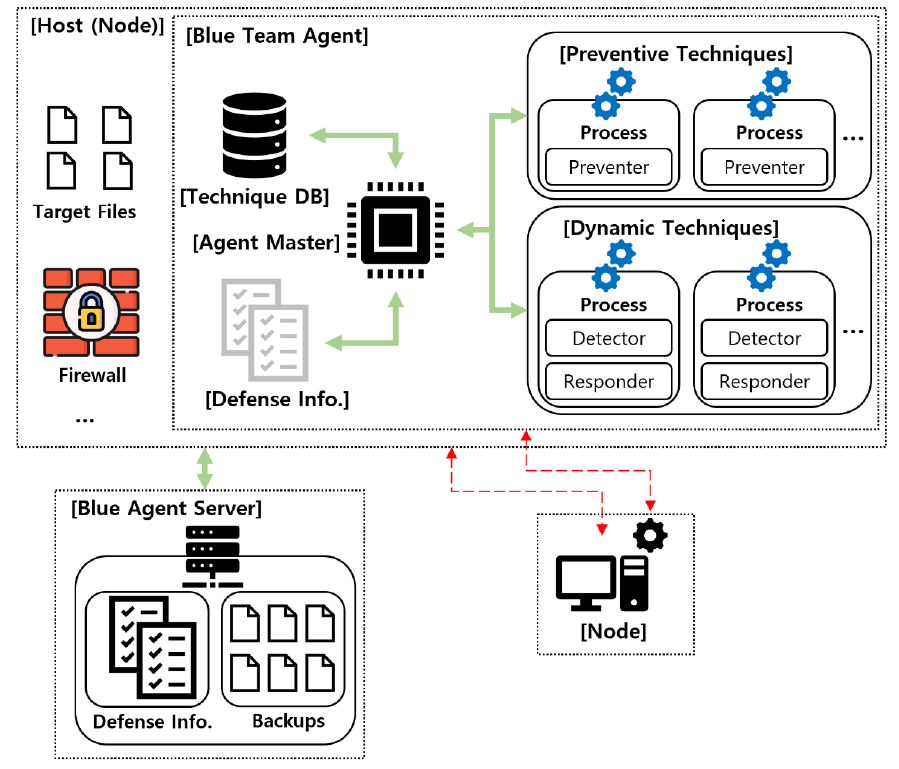
Figure 14. Overall architecture of blue team agent and blue team